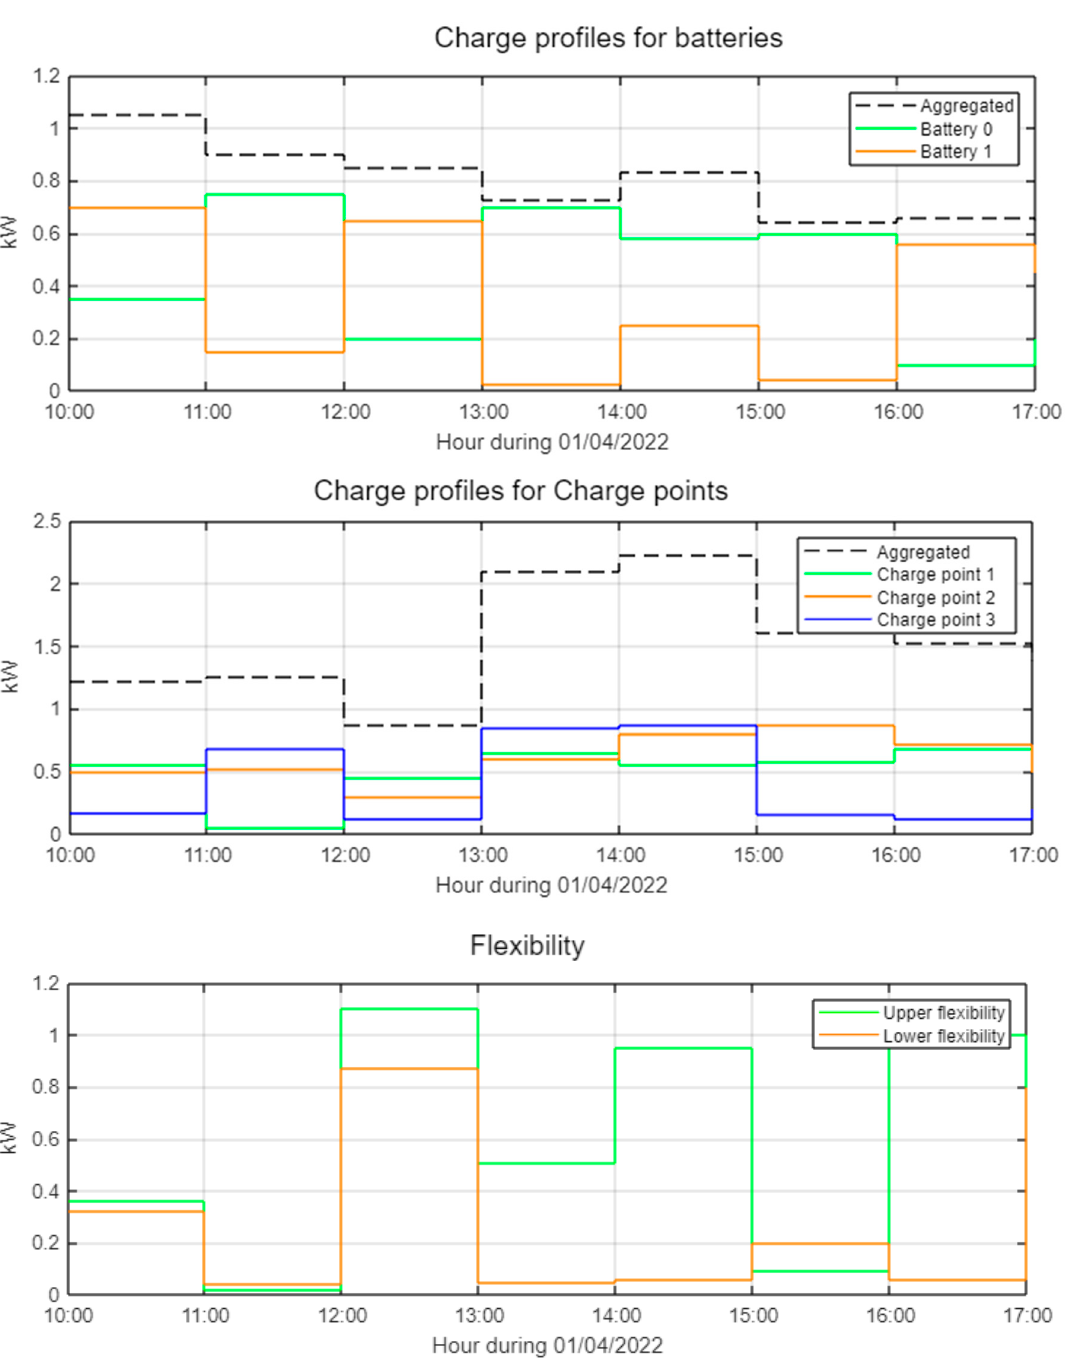
Figure 3. SCT calculation-Charge profile calculated with